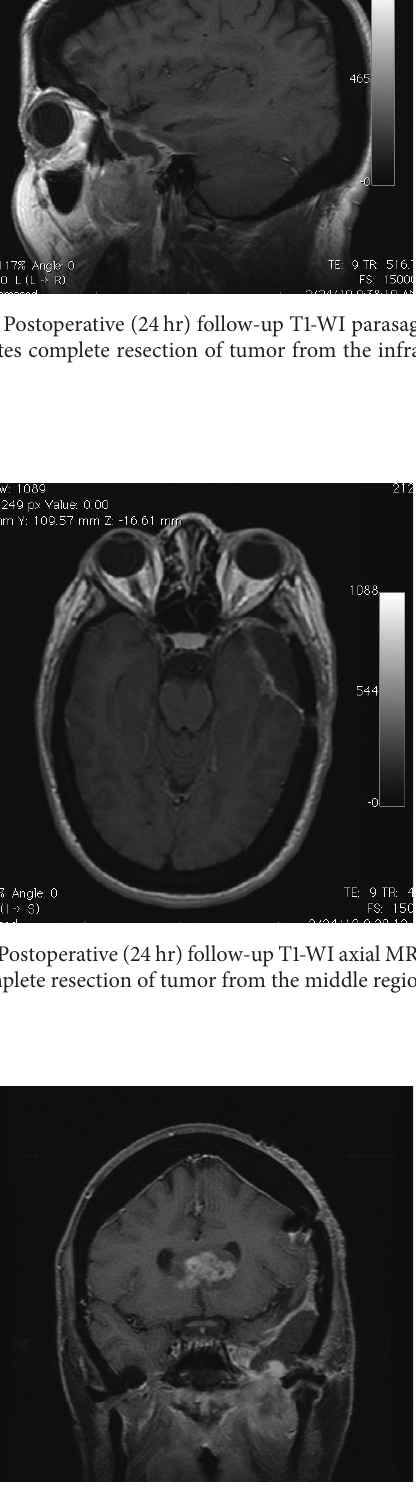
Figure 12: Postoperative (8-month) follow-up T1-WI axial MRI demonstrates recurrent local tumor, likely from anaplastic astrocy- toma component, and distant spread to the anterior part of corpus